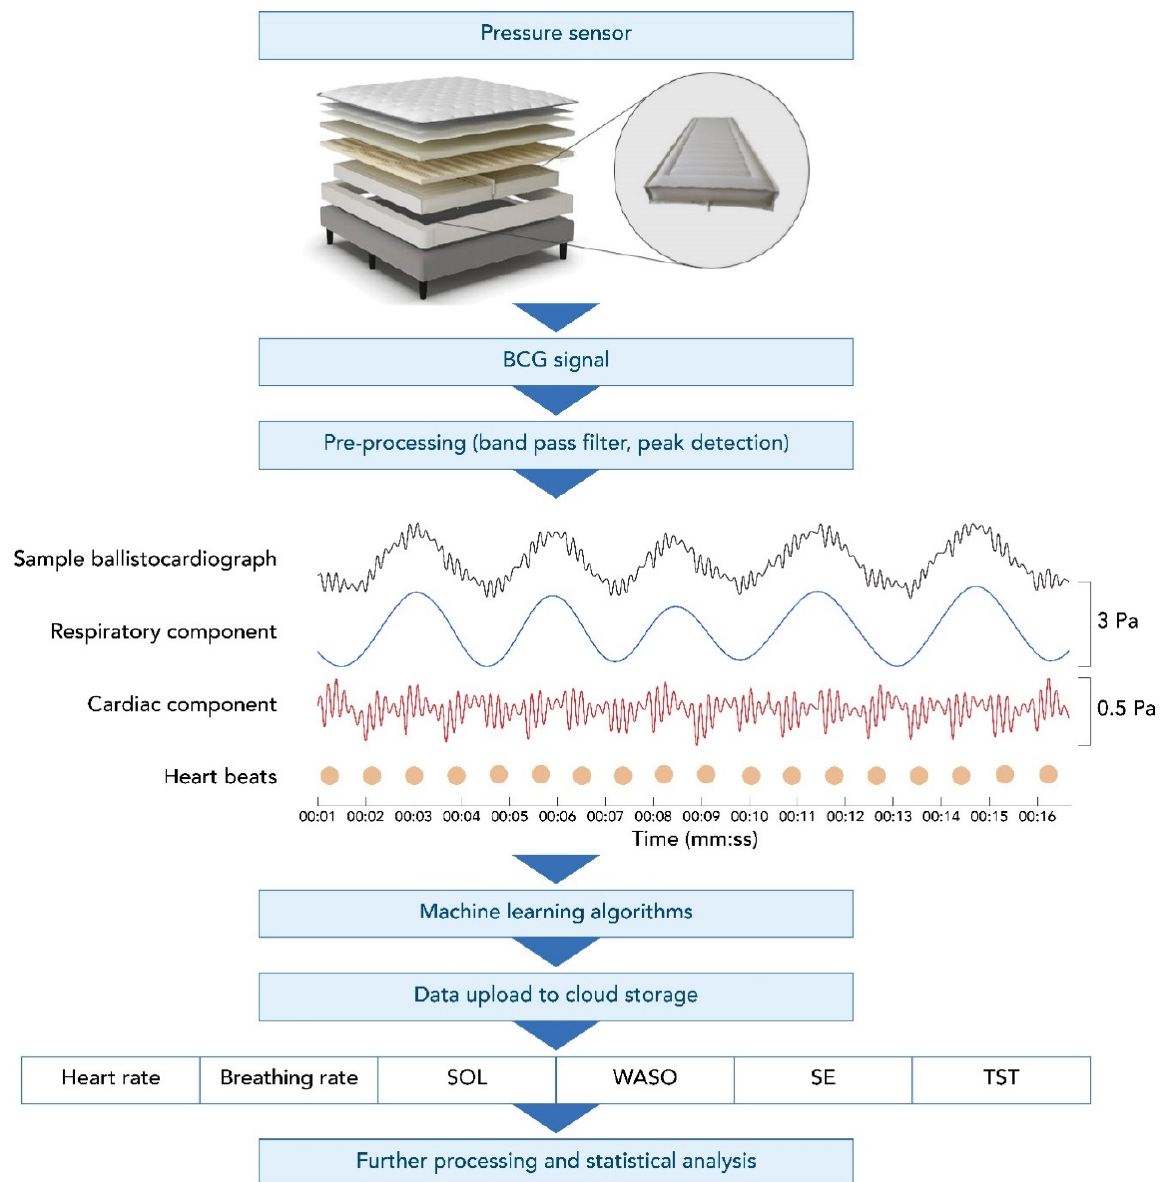
Figure 1. The smart bed setup, ballistocardiograph, and subsequent output. A BCG recording using the smart bed technology (black, top row of middle panel) during a motionless, 16 s recording segment decomposed into the respiratory pattern (blue, second row of middle panel) and heart activity (red, bottom row of middle panel). The dots denote detected individual heartbeats. Vertical axes are pressure readings in pascal units scaled for better visualization. BCG, ballistocardiography; SE, sleep efficiency; SOL, sleep onset latency; TST, total sleep time; WASO, wake after sleep onset.